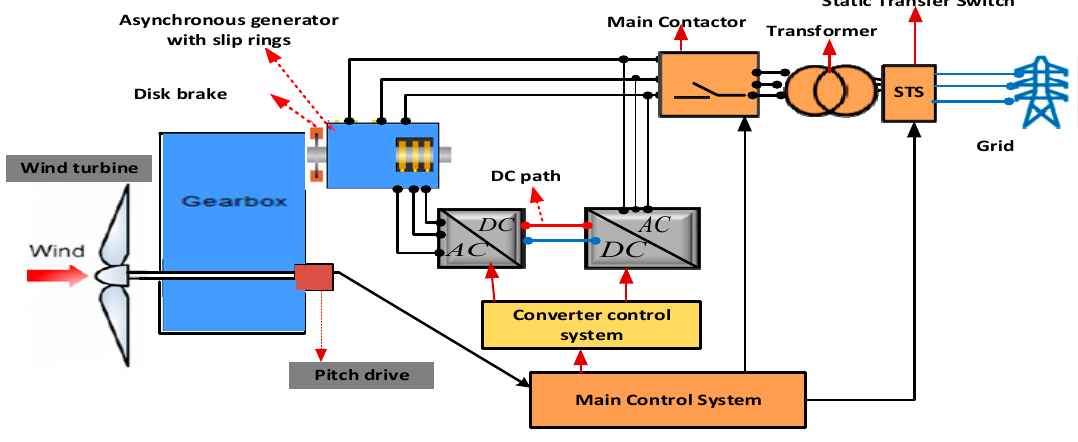
Figure 9. Schematic diagram of speed control.